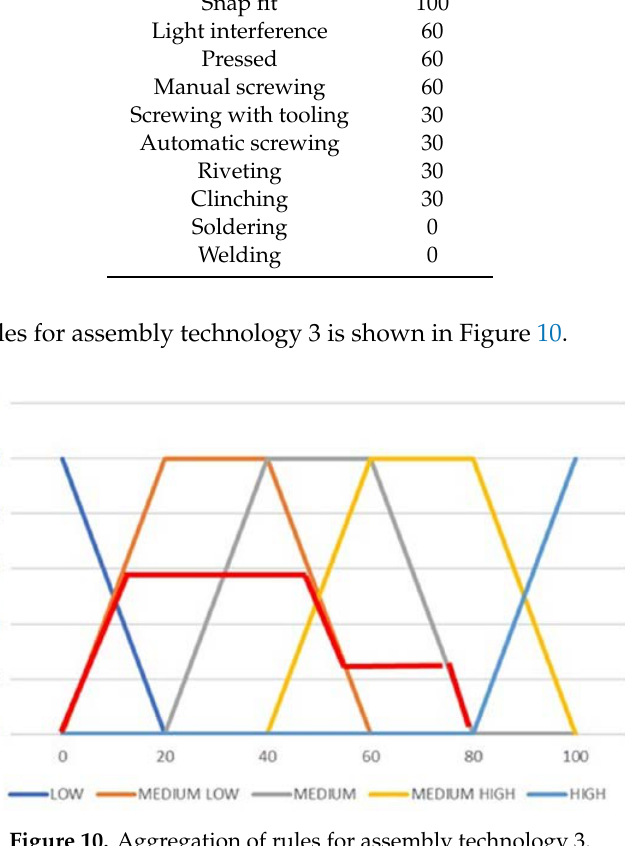
10 Figure 10. Aggregation of rules for assembly technology